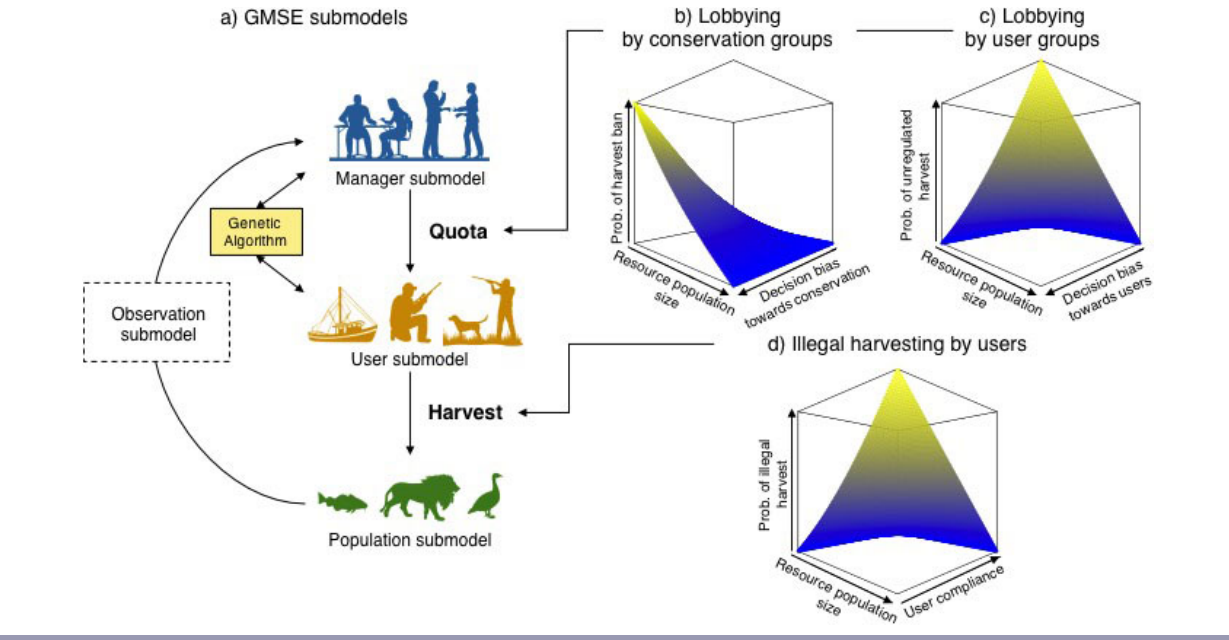
Fig. 1 . Overview of the generalized management strategy evaluation (GMSE) approach used in this